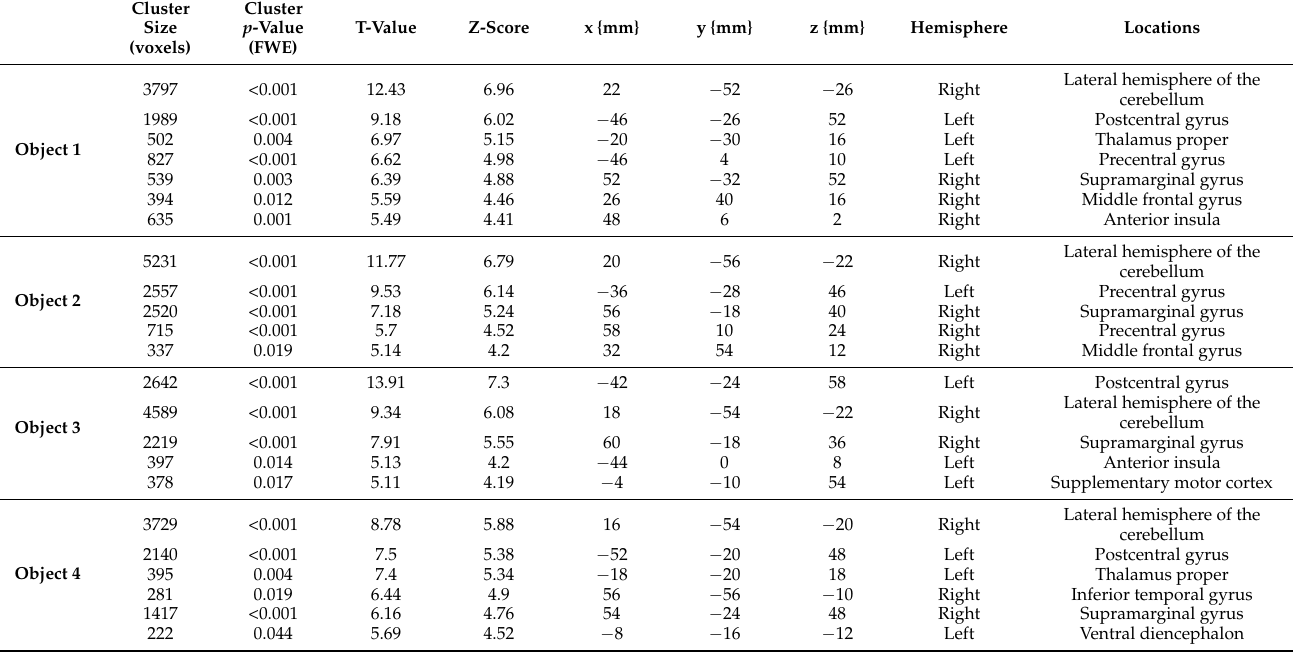
Table 2. Significantly activated areas and their T-values and coordinates when grasping each object.